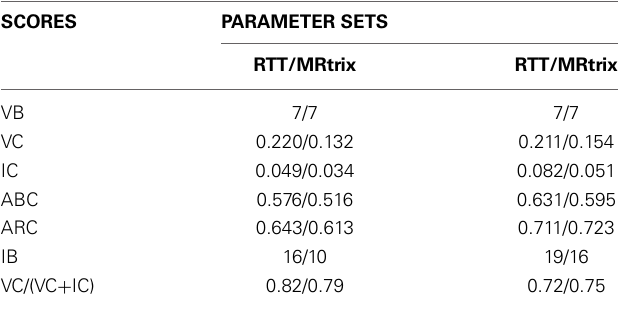
Table 3 | Pair-wise comparison between Tractometer scores for the best set of parameters (issued from Table 2) in both RTT and MRtrix